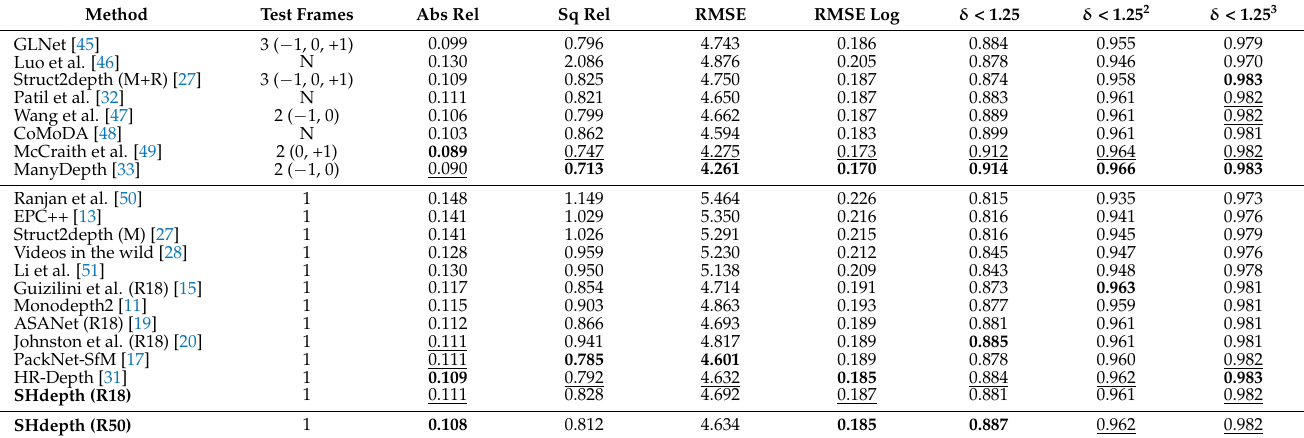
Table 3. Quantitative results. Comparison of our SHdepth to other existing methods on KITTI. Best results in each category are in bold and second best are underlined. The R18 in the method column means that the encoder is ResNet-18 and R50 is ResNet-50. For error evaluating metrics Abs Rel, Sq Rel, RMSE, and RMSE log, lower is better. For accuracy evaluating metrics δ < 1.25, δ < 1.25 2 and δ < 1.25 3 , higher is